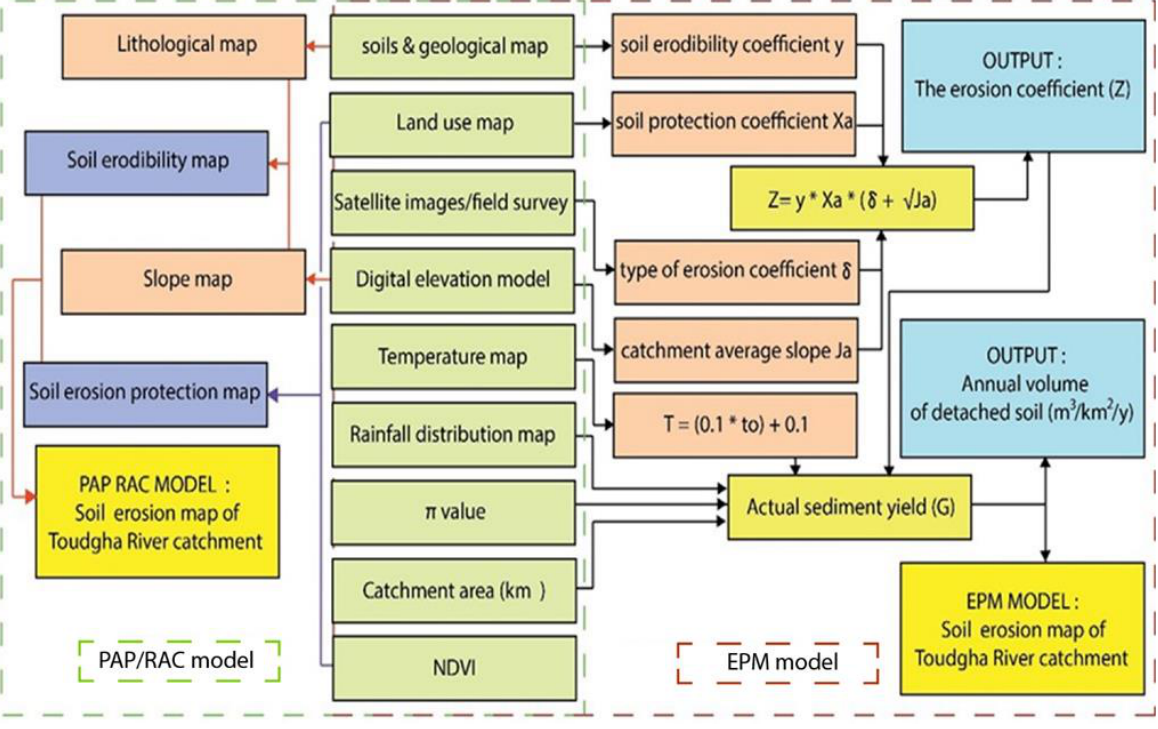
Figure 3. Methodology adopted for running the EPM and PAP/RAC models under GIS software.